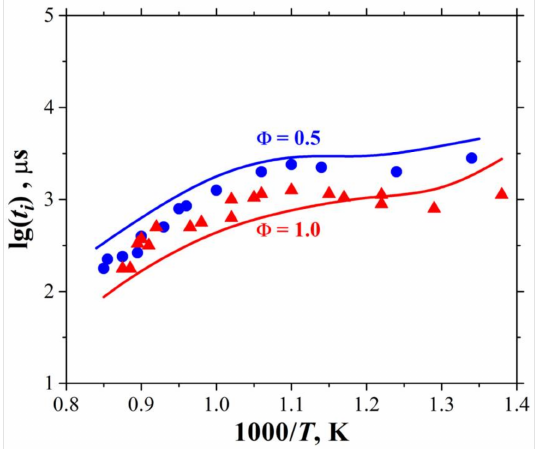
Figure 4. Calculated (curves) and measured (symbols) dependences of the ignition delay time on temperature for n-dodecane–air mixtures with Φ = 0.5 and 1.0 at P = 20 bar.